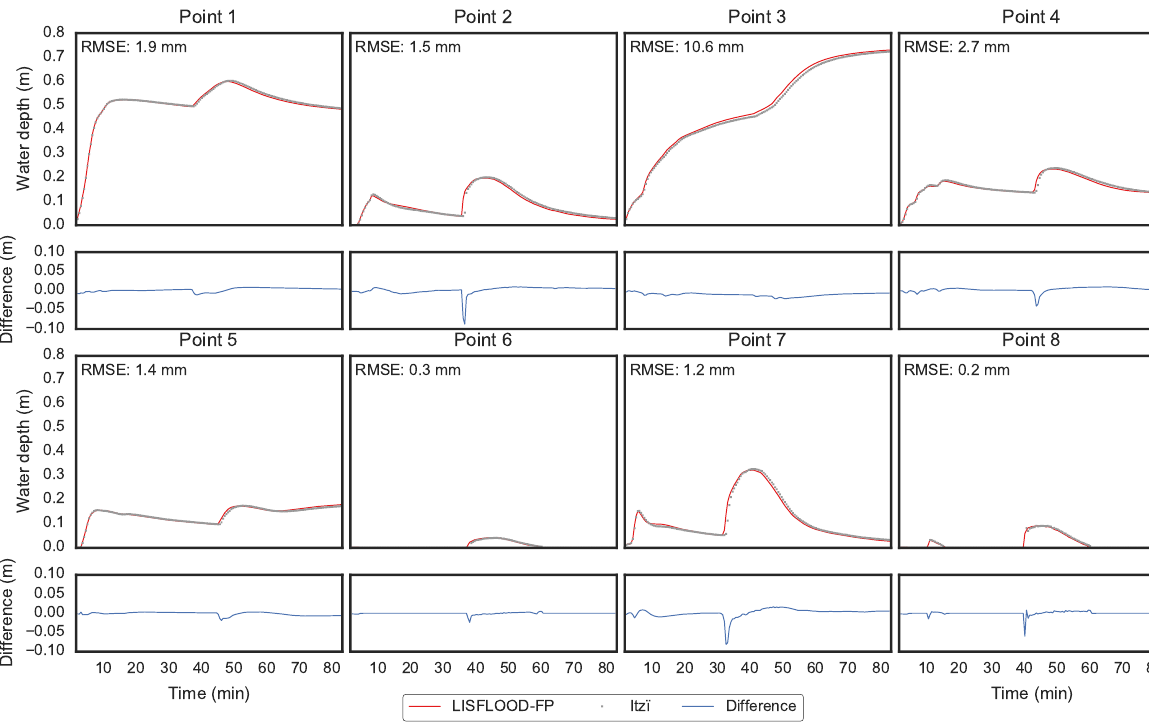
Figure 6. DEM of EA test 8a showing the numbered control points (crosses) and inflow point (triangle).